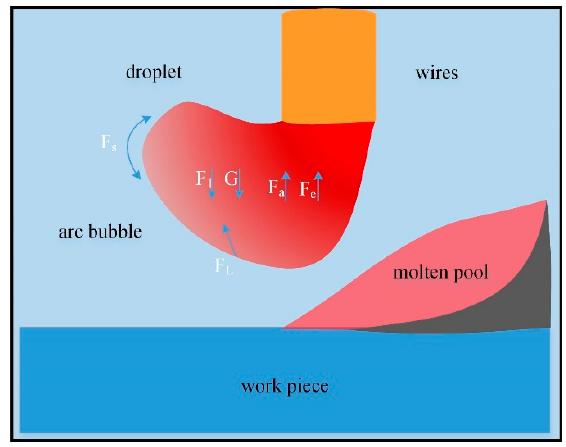
Figure 14. Schematic of forces analysis for globular repelled step.